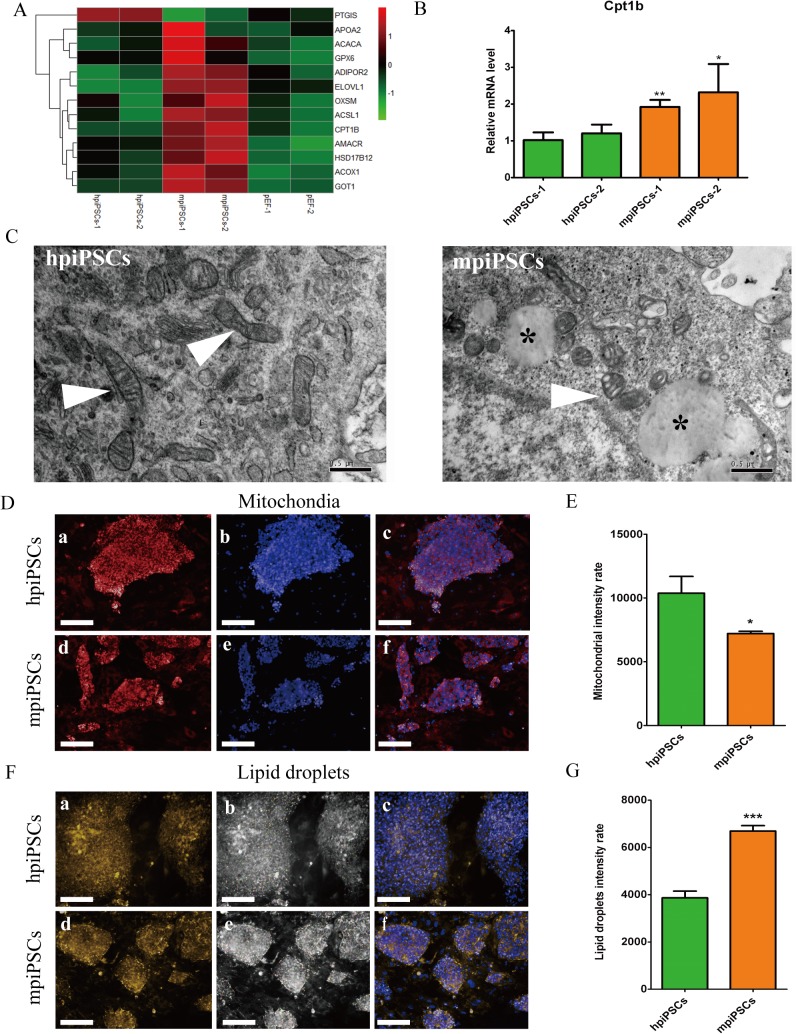
Metabolic features of the two types of piPSCs.(A)Heatmap of selected genes involved in metabolism. (B) Relative mRNA levels of Cpt1b in hpiPSCs and mpiPSCs. *p < 0.05, **p < 0.01 (mean ± SD, n = 3) (C) Electron microscope images of hpiPSCs and mpiPSCs. White arrowheads indicate for mitochondria and black asterisks indicate lipid droplets. Bar scale = 0.5 μm. (D) The Mitotracker staining of piPSCs. Mitotracker deep Red (a and d), Hoechst (b and e), overlay (c and f). Bar scale = 100 μm. (E) Mitochondrial membrane intensity rate (intensity of fluorescence / cell areas (μm2)) of piPSCs. *p < 0.05 (mean ± SD, n = 3) (F) The Nile Red staining of piPSCs. Nile Red (a and d), lipid droplets detected in piPSCs’ colonies by “Harmony” software. Lipid droplets labeled by color circles (b and e), Nile red and Hoechst overlay (c and f). Bar scale = 100 μm. (G) Lipid droplet intensity rate (intensity of fluorescence / cell areas (μm2)) of piPSCs. ***p < 0.001 (mean ± SD, n = 3).